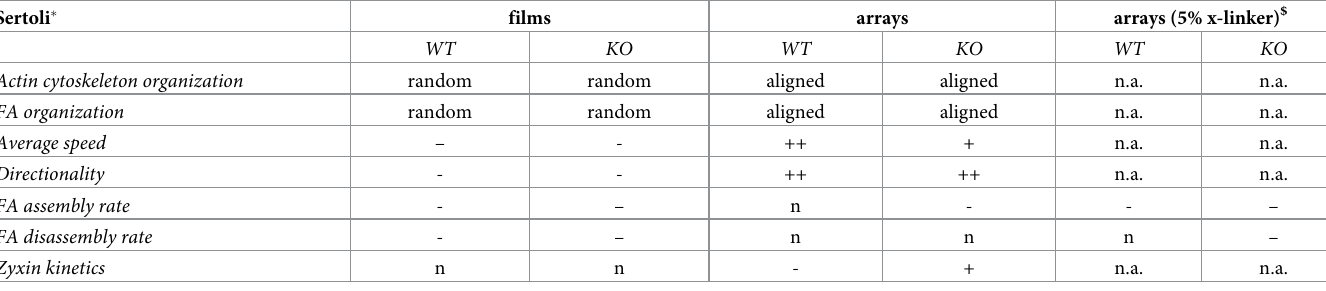
Table 3. Summary of the impact of microgels on the behavior of WT and KO Sertoli cells. Sertoli